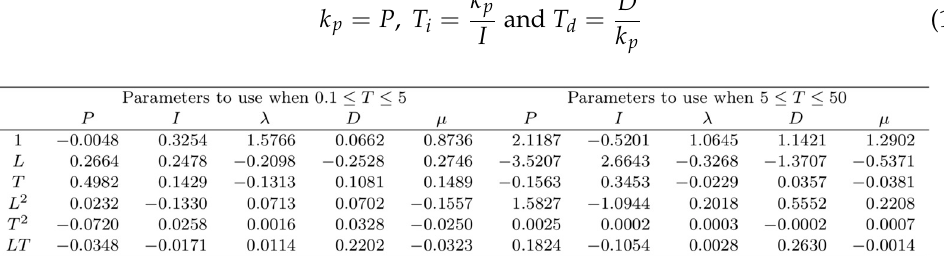
Figure 5. Parameters for the second set of tuning rules for S-shaped response processes ( P = k p , I = k p /T i , D = k p T d ) [32]. 3. Direct Fractional Order Autotuning Methods Most of the direct autotuning methods are based on using the relay test to determine the process critical gain and critical period of oscillations, but other methods have been developed [34]. Several generalizations of the Ziegler-Nichols ultimate gain method have been pro- posed over the years for the tuning of FO-PIDs. A new tuning method for such a controller that combines both the Ziegler-Nichols as well as the Astrom and Hagglund methods has been proposed in [35]. The idea is based on obtaining the process critical frequency and critical gain and then computing the k p and T i parameters using the classical Ziegler-Nich- ols method. For a specified phase margin, the T d parameter is computed using the Astrom and Hagglund method. Two equations referring to the controller’s real and imaginary parts are obtained. Fine tuning of T d is employed to achieve the best numerical solution of the equations, for each specified phase margin. Matlab ® ’s built in functions, such as fsolve, are used to solve the two equations to obtain numerical values of λ and μ by considering the new value of T d for each specified phase margin. An optimization Simulink model is used to obtain a better step response. The least squares method is used in the optimization model and the optimized FO-PID parameters are obtained. The approach is tedious and involves three controller designs before the final optimized FO-PID is obtained. However, the design allows for a direct specification of the loop phase margin.